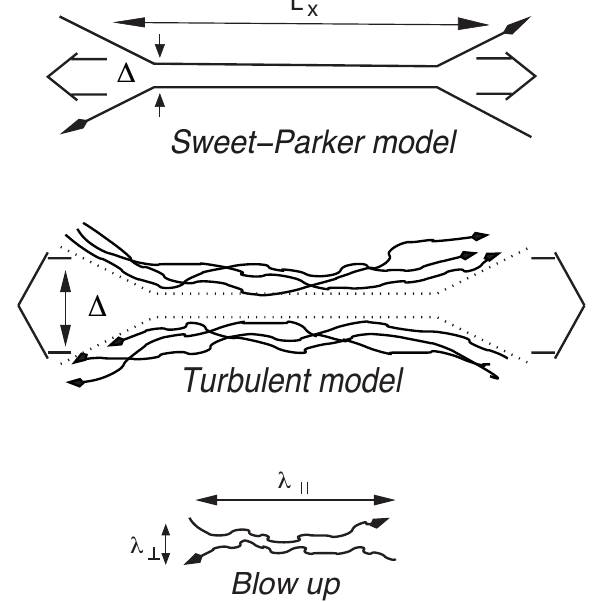
Fig. 1. Upper plot : Sweet-Parker model of reconnection. The outflow is limited by a thin slot ∆ , which is determined by Ohmic diffusivity. The other scale is an astrophysical scale L ≫ ∆ . Middle plot : Reconnection of weakly stochastic magnetic field according to LV99. The model accounts for the stochasticity of magnetic field lines. The outflow is limited by the diffusion of magnetic field lines, which depends on field line stochasticity. Low plot : An individual small scale reconnection region. The reconnection over small patches of magnetic field determines the local reconnection rate. The global reconnection rate is substantially larger as many independent patches come together. From Lazarian, Vishniac & Cho 2004.